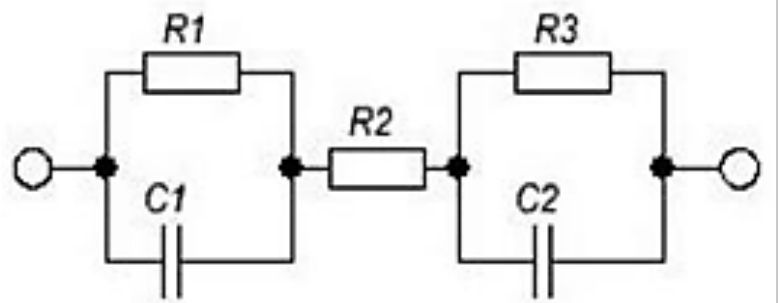
Figure 2. The simulator electrical scheme of biological tissue electrical characteristics with concentrated parameters in a magnetic